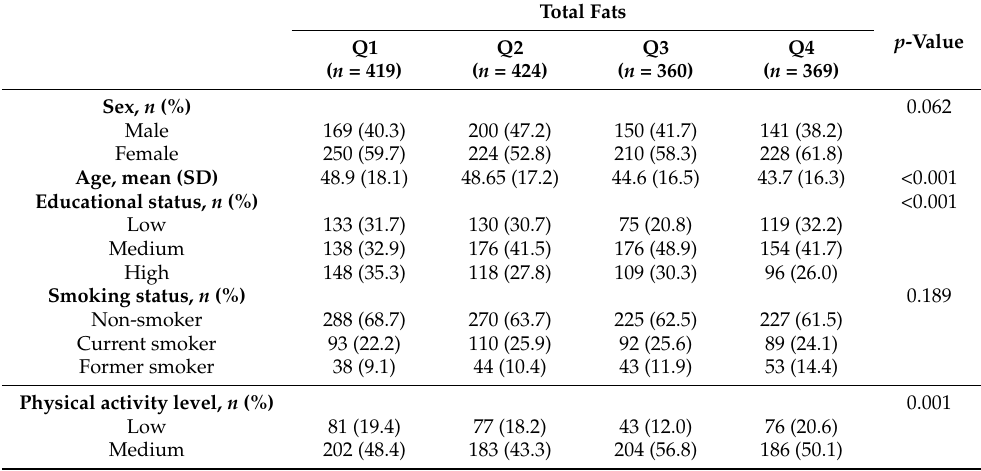
Table 1. Background characteristics of the study sample by consumption of total dietary fats ( n =